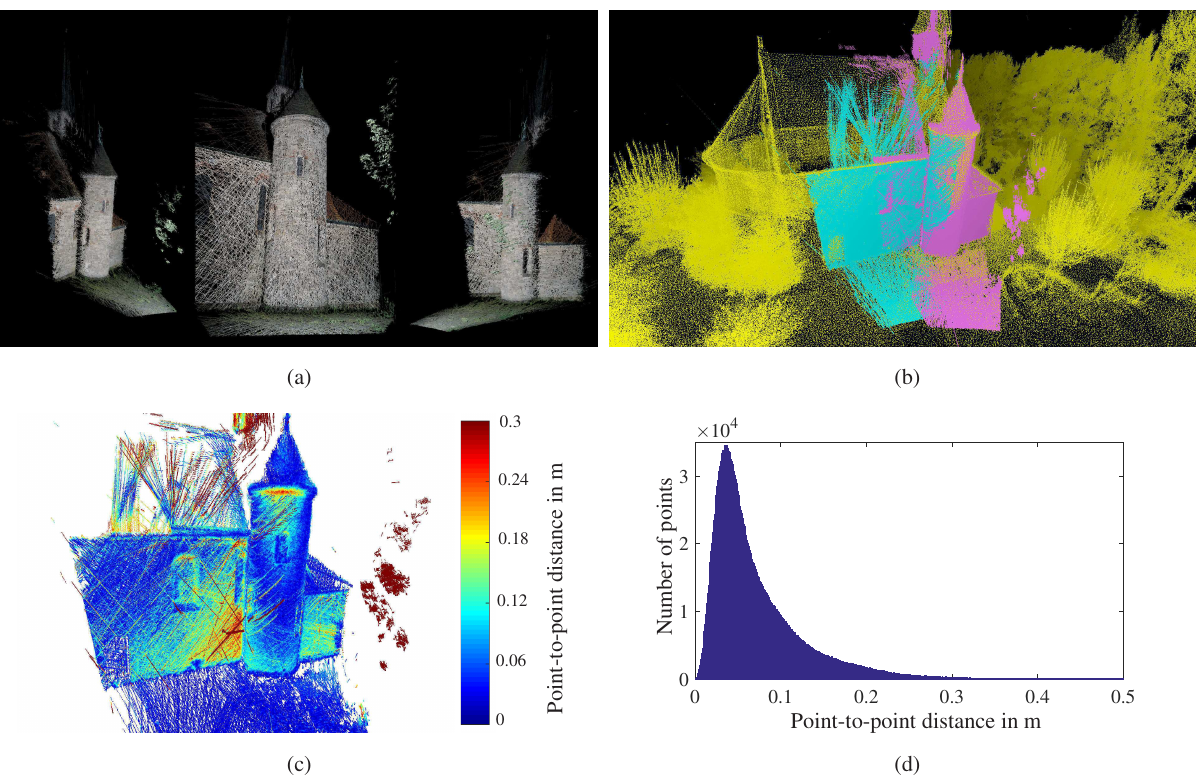
Figure 6: Scans of a chapel and comparison with LiDAR data captured using a Riegl VZ-400: (a) three views of a scan created using the proposed method, (b) LiDAR data in yellow and two scans using the proposed method in pink and turquoise, (c) visualization of the result using the proposed method colored with the distance from the LiDAR point cloud, (d) histogram of the point-to-point